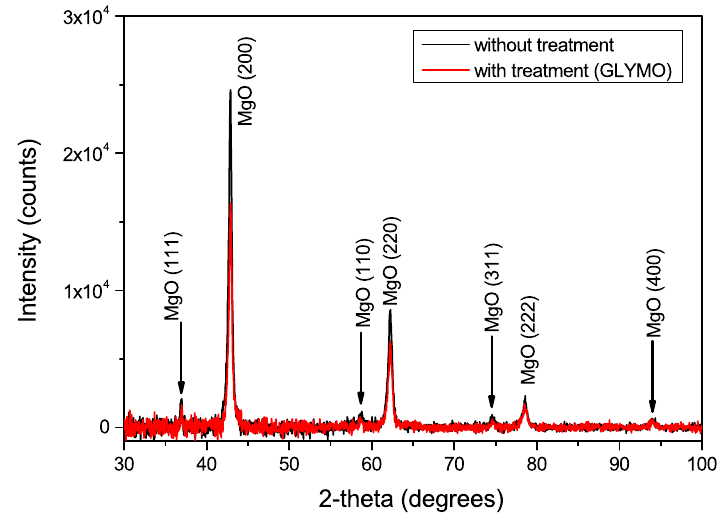
Figure 10. X-ray diagram of treated and untreated MgO